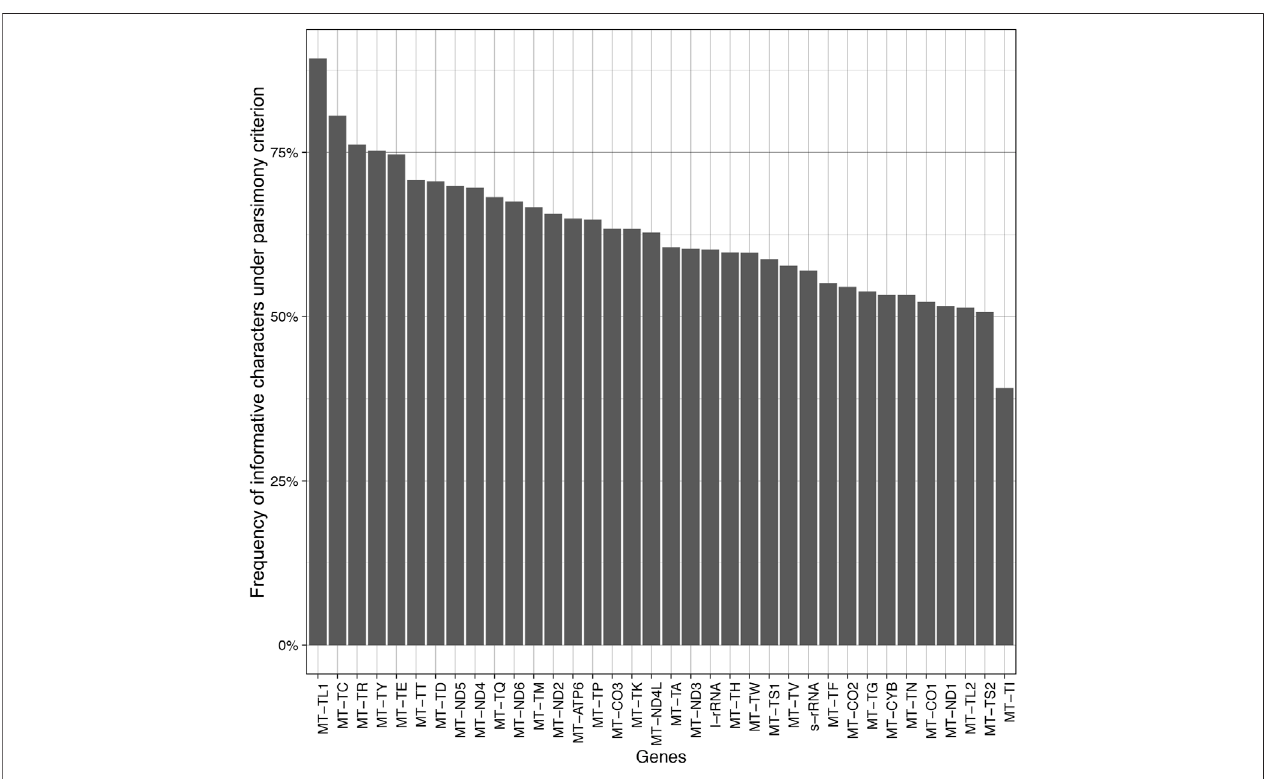
FIGURE 6 | Barplot of the frequency of informative characters under the parsimony